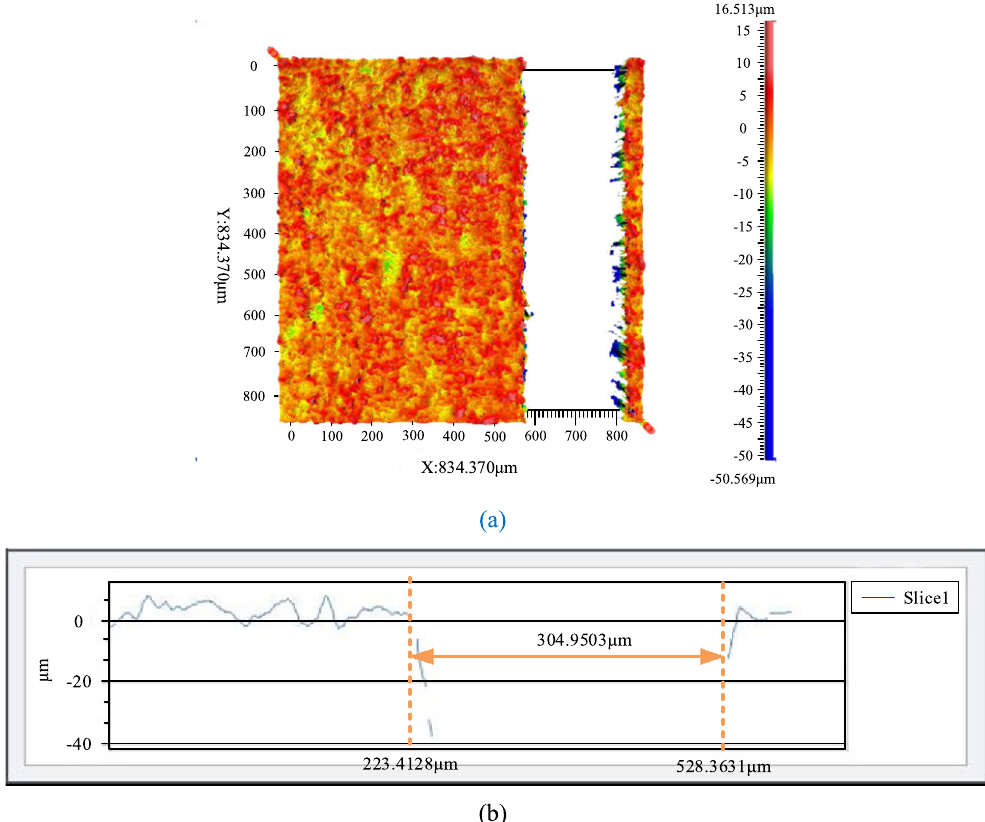
Figure 2: On - line detection of kerf width under the ON is 20 μ s, OFF is 95 μ s, IP is 8.5 A, SV is 30 V, and SF is 5.0 mm · min − 1 : ( a ) three - dimensional graphics and ( b ) identi fi cation.